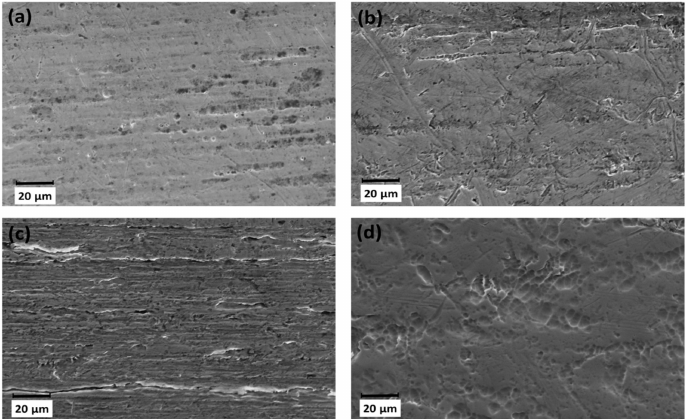
Figure 3. Representative SEM micrographs at 2000 × magnification of ( a ) NiTi_Vis Plus, ( b ) NiTi_Azdent, ( c ) β -Ti_Ormco and ( d ) β -Ti_Azdent. The scale bar is 20 µ m.